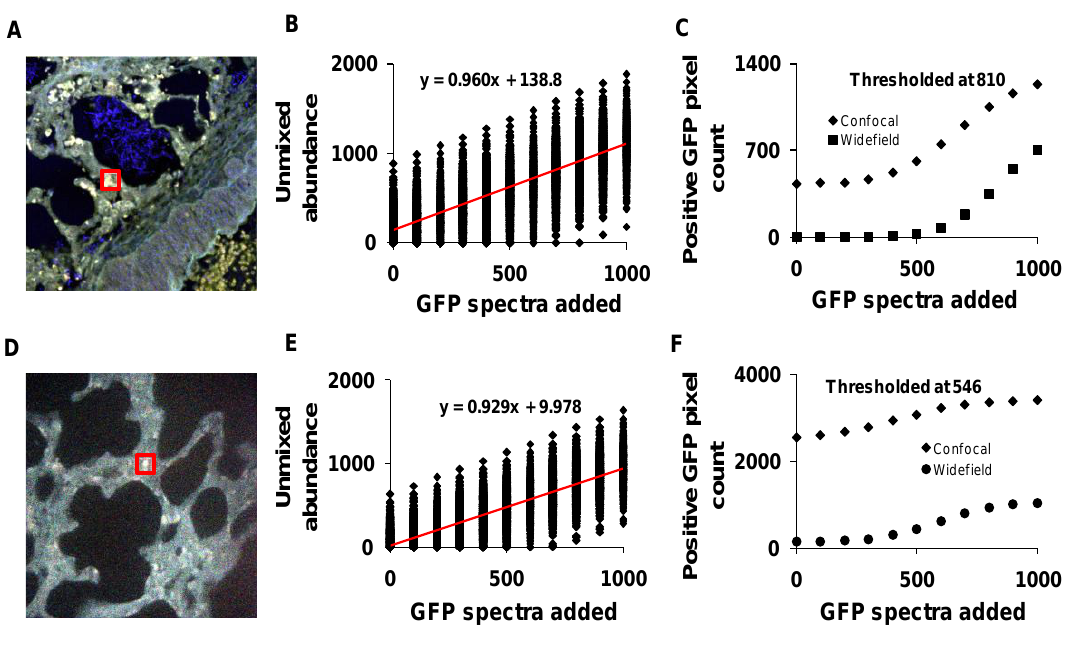
Figure 11. Known amounts of green fluorescent protein (GFP) spectra were added to a 30 × 30 pixel square region in the control (with no GFP and Hoechst) hyperspectral images to measure the theoretical sensitivity of the hyperspectral confocal and widefield microscope systems. Spectral images were then linearly unmixed and the GFP abundance for each pixel in the 30 × 30 region was plotted as a function of the GFP signal added (panels B and E, for confocal and widefield, respectively). The red line in panel B and E indicates the linear fit between the GFP added and GFP detected (e.g., at 1,000 pixels added almost all 1,000 pixels were detected). The minimum detection threshold for GFP-positive pixels was defined as the 98.5% quantile at 0% GFP added. Using this threshold (810 for confocal and 546 for widefield), the number of GFP-positive pixels in the entire image was measured and plotted as a function of the GFP signal added (panels C and F, for confocal and widefield,